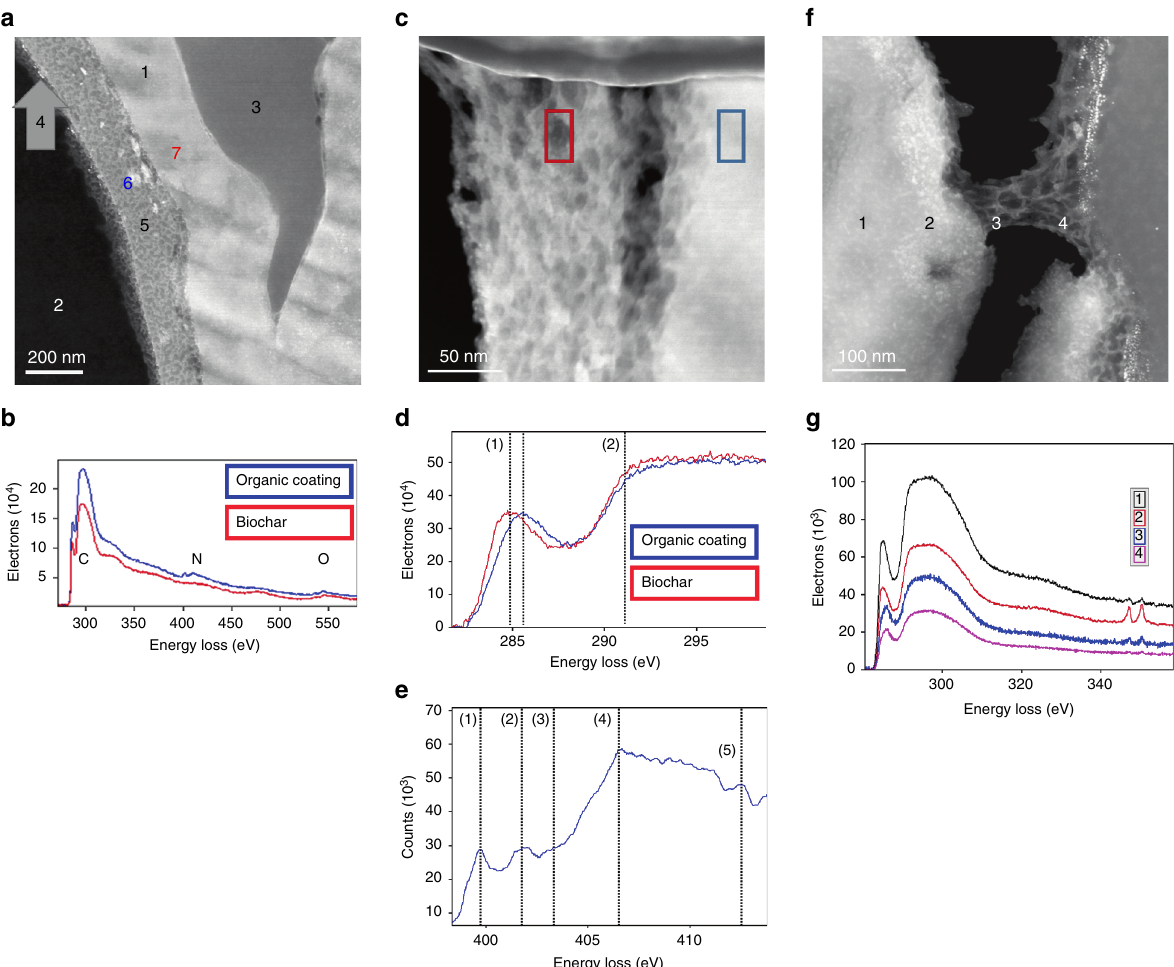
Fig. 5 Scanning transmission electron microscopy and electron energy loss spectroscopy of organic coating on co-composted biochar. Micrographs were obtained from different ultra-thin sections of the same biochar particle. a , b STEM HAADF micrograph and EELS spectra of an ultra-thin section of co- composted biochar revealing an organic coating. Position 1: biochar with N and O below detection limit of EELS; 2: epoxy resin; 3: empty hole (resin did not penetrate this pore); 4: gold that was sputtered onto the biochar particle before embedding to identify the sample surface; 5: organic coating, porous appearance, contains N and O according to EELS spectra shown in b ; 6 and 7: Location of EELS sum spectra shown in b . b EELS spectra revealing only minor differences in C speciation between biochar (red) and organic coating (blue), but considerably increased content of N in the coating. Letters indicate absorption edge (K shell) of C, N and O. c Closeup on a region of thick (~120 nm) organic coating, probably located inside a biochar pore (no gold coating detectable). d C-K near edge EELS spectrum of biochar matrix and coating as marked in c showing a peak shift of the C = C 1s – π * transition (1) of aromatic carbon by ~0.5 eV (284.9 – 285.5eV). C – C 2s-2pz σ * transition (2) was not altered (291.2 eV). e N-K near edge EELS spectrum of coating as marked in c showing (1) imine N 1s – π * transition at 399 – 400eV; (2) amide N 1s – 3p/ π * transition at 401.3 eV; (3) nitro N 1s – π * transition at 403.6 eV; (4) corresponds